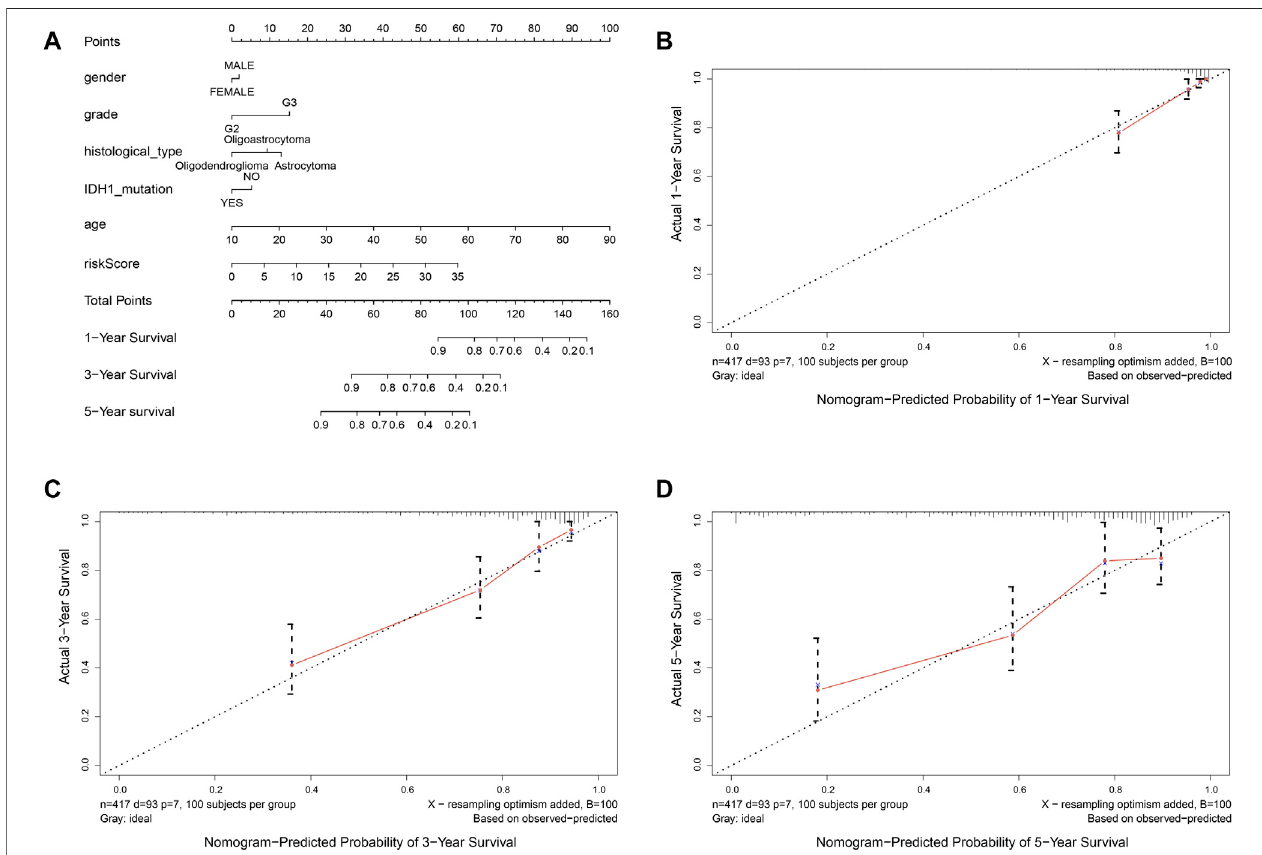
FIGURE 8 | Nomogram to predict the overall survival of patients who suffer from LGG. (A) nomogram to predict 1-, 3-, or 5-year OS. (B-D) calibration curve for nomogram to predict 1-, 3-, or 5-year OS. The x -axis is nomogram-predicted survival, and the y -axis is actual survival. The reference line is 45 ◦ inclined and indicates perfect